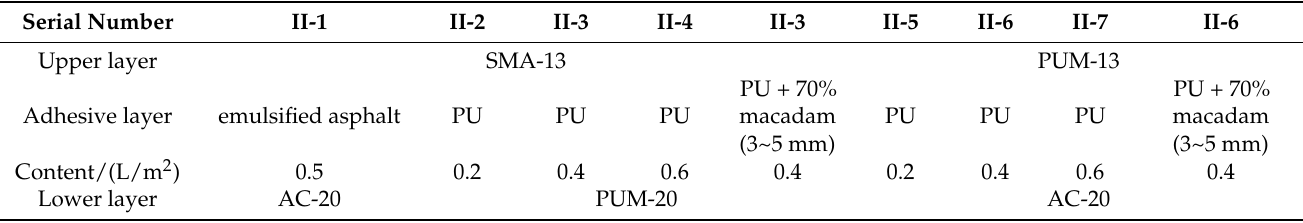
Table 5. Composite specimens with adhesive layer.